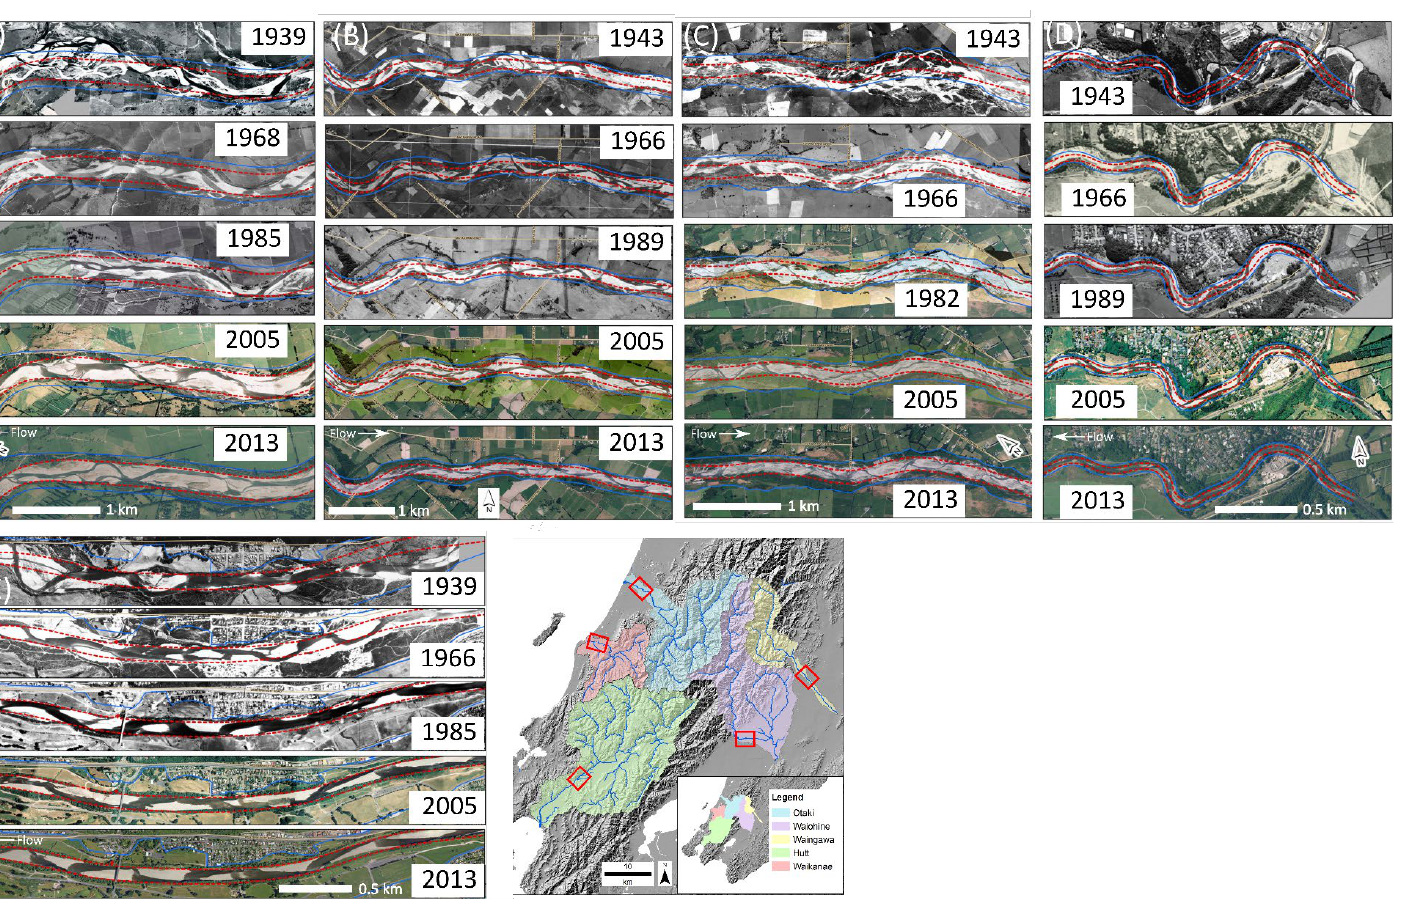
Figure 4. River channel changes from ca.1940s to 2010s, Greater Wellington Region: ( A ) Ōtaki, ( B ) Waiohine, ( C ) Waingawa, ( D ) Waikanae, ( E ) Hutt, showing channel rationalisation, simplification, narrowing and straightening impacts of river management under a ‘control’ ethos. Locations of reaches shown using boxes in inset. Red lines are the river design channel alignment, blue lines delineate river corridor boundary. All images were provided courtesy of Phil Cook, Greater Wellington Regional Council.